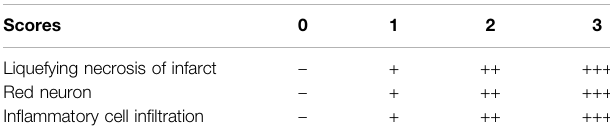
TABLE 2 | Semi-quantitative injury score standards.